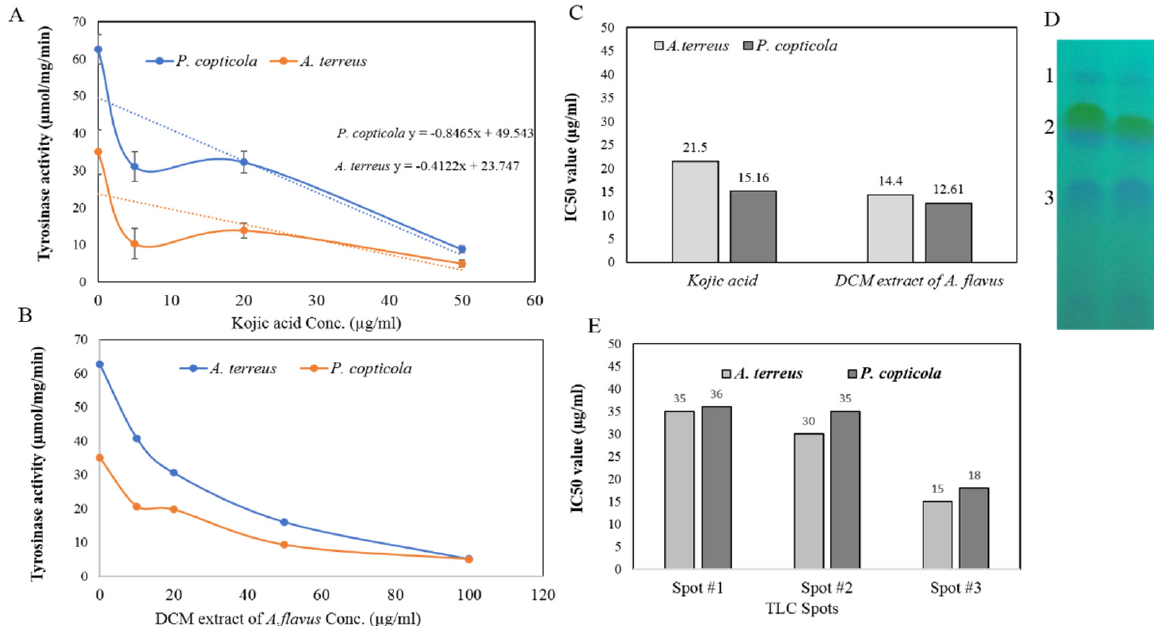
Figure 6. Kinetics of inhibitions of tyrosinases from A. terreus and P. copticola by kojic acid and DCM extracts of A. flavus . Different concentrations of kojic acid ( A ), and A. flavus extracts ( B ) were added to the reaction mixture, and the enzyme activity was measured. ( C ) The IC 50 values of kojic acid and A. flavus DCM extract for the enzyme from both fungal isolates. ( D ) TLC chromatogram of the DCM extract of A. flavus. ( E ) The IC 50 values of the three putative spots #1, 2, and 3 for inhibition of tyrosinase of A. terreus and P. copticola .